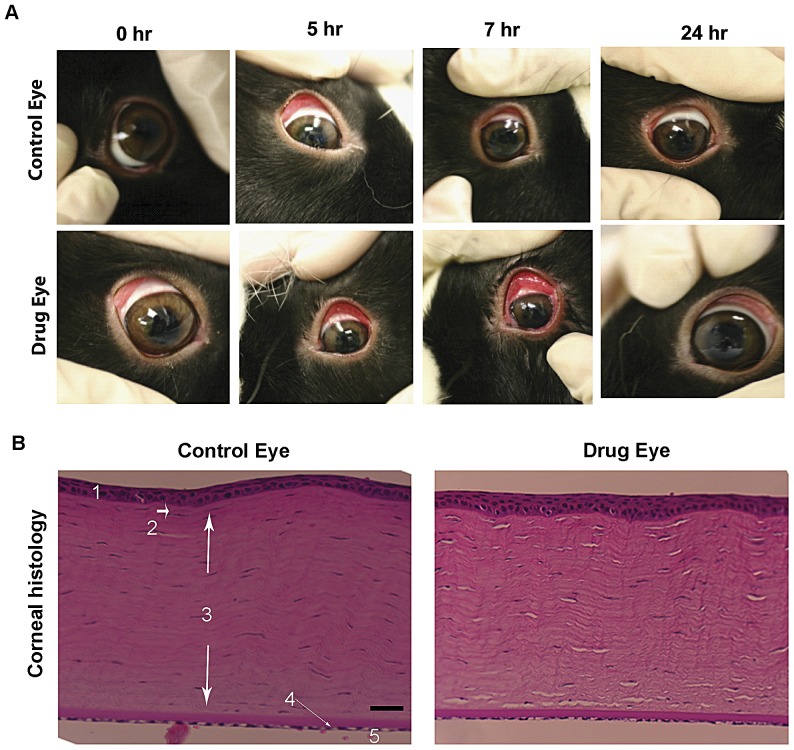
Effects of topical application of S32826 on the rabbit cornea.A. Topical application of 10 mM S32826 (twice daily, 35 µl aliquots) in Dutch-Belted adult male rabbits caused conjunctival hyperemia within the first 2 hrs after drug application, in association with drug precipitation on the cornea and conjunctival tissue as a fine thin film. However, hyperemia and all evidence of drug precipitation disappeared within 24 hrs following drug application. B. Topical effects of S32826 on rabbit corneal histology. Rabbits treated with a topical dose of 5 mM S32826 for 5 days (single daily dose) and which showed a decrease in IOP were enucleated and examined for corneal histological changes relative to sham treated specimens. As shown in the figure, drug application did not cause any apparent change on the integrity of corneal epithelium, endothelium, Bowman's layer, Stroma or Descemet's membrane (based on hematoxylin and eosin staining) relative to the control cornea. Bar: 10 µm. Labels: 1. Corneal Epithelium; 2. Bowman's layer; 3. Corneal Stroma; 4. Descemet's membrane; 5. Corneal Endothelium.